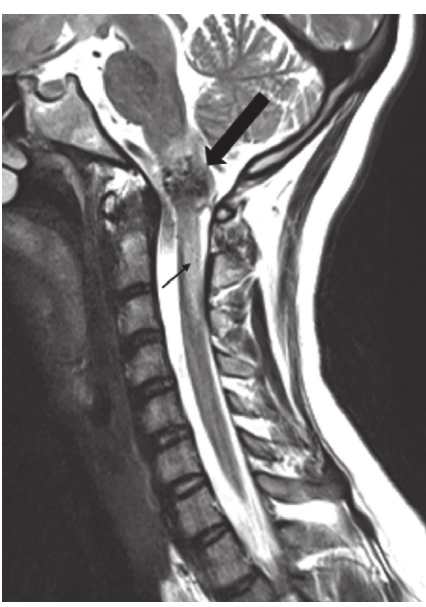
Figure 2: Sagittal T2-weighted MR image of the cervical spine demonstrating the expansile nidus of flow voids at the cervico- medullary junction (large arrow). Edema in the adjacent brainstem extends into the upper cervical spinal cord to the C3 level (thin